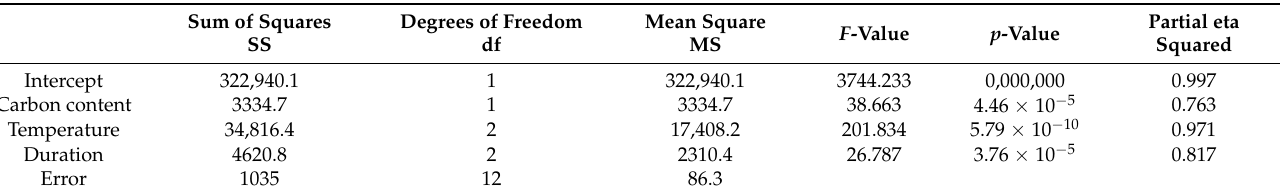
Table 4. Analysis of variance for the boride layer thickness.